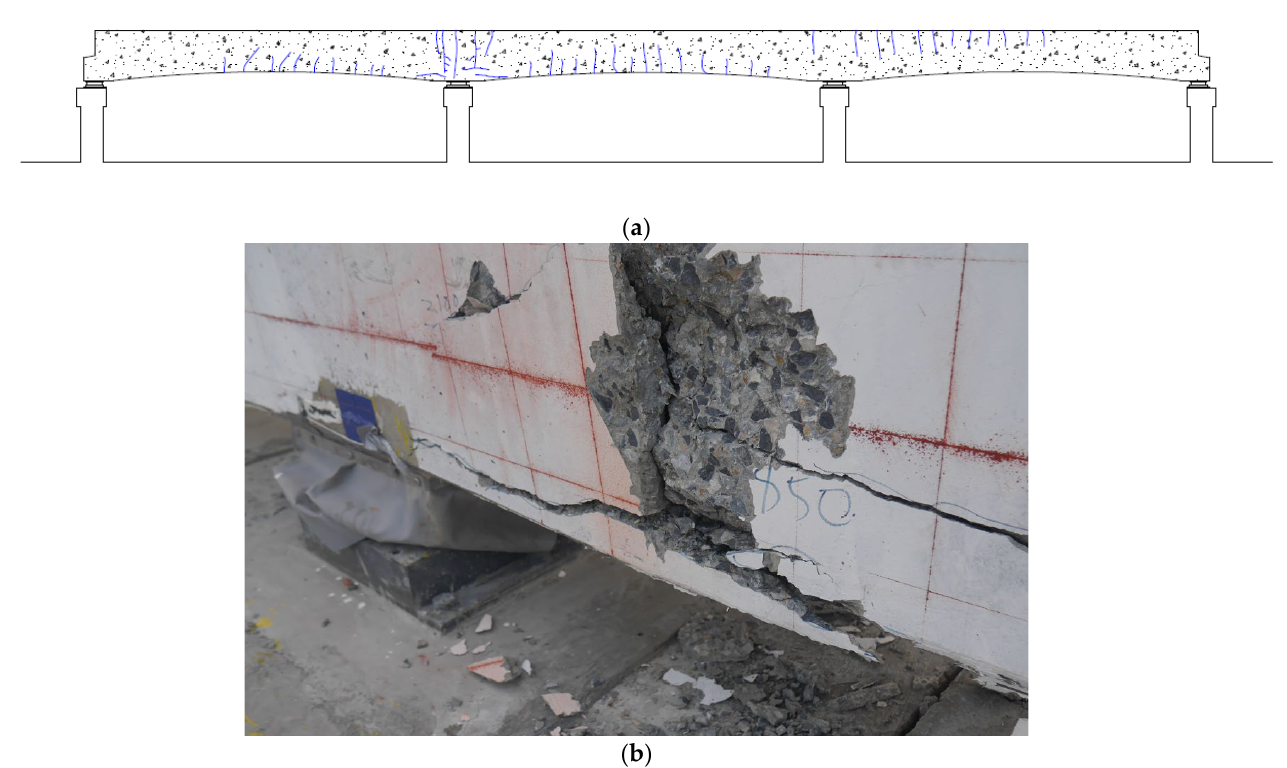
Figure 50. Ultimate failure of specimen SP-1, ( a ) line diagram, ( b ) concrete crushing.